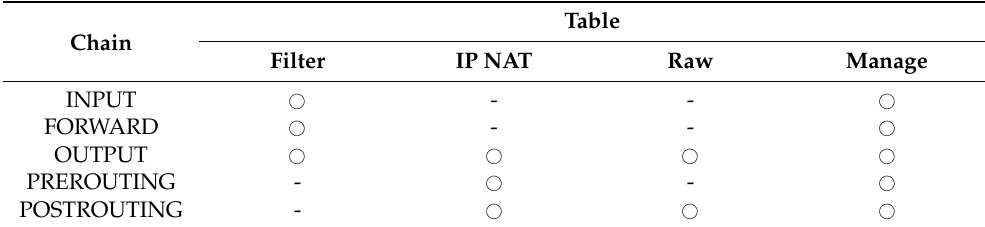
Table 2. Iptables table and chain based on Linux.